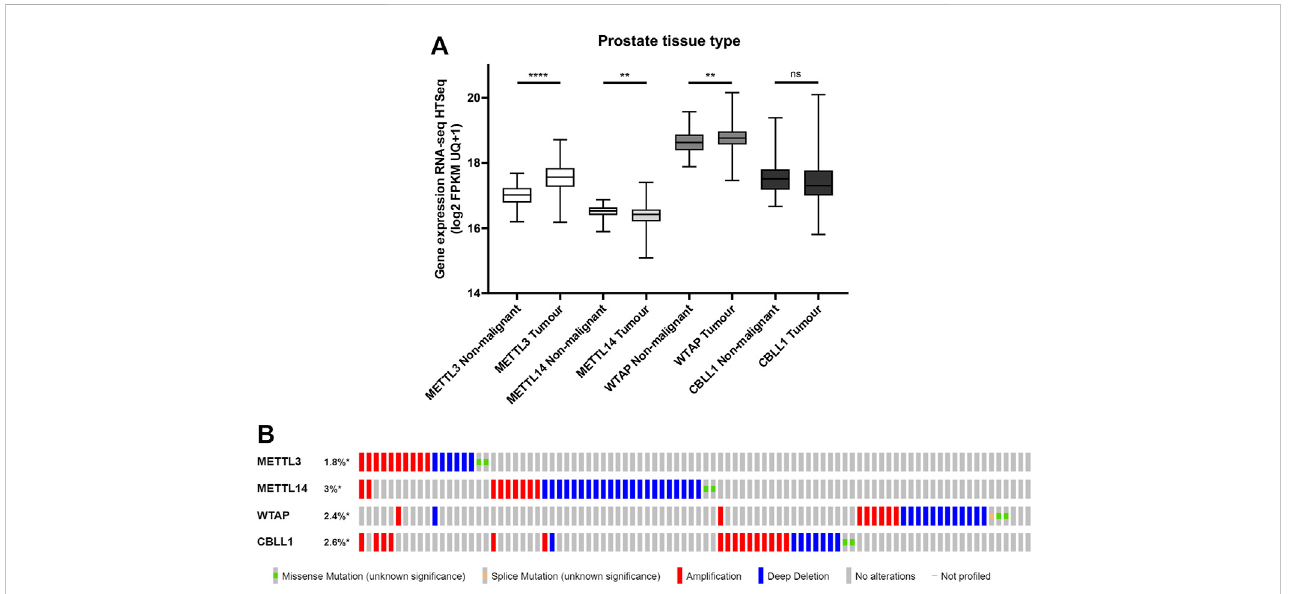
FIGURE 1 METTL3, METTL14, WTAP and CBLL1 expression in non-malignant and PCa tissue and genetic alteration analysis. Data from the GDC TCGA Prostate Cancer(PRAD)datasetweredownloadedfromUSCSXena[ (A) ; n =623]. METTL3,METTL14,WTAP and CBLL1 expressioninnon-malignantprostatetissuewas comparedwithprimaryprostateadenocarcinomaspecimens.ThecBioPortalforCancerGenomicswasutilisedtoassesstheincidenceofampli fi cation,deep deletion and mutation of METTL3, METTL14, WTAP and CBLL1 in patients with adenocarcinoma, metastatic adenocarcinoma and neuroendocrine PCa [ (B) ; n = 1,059]. ns, not signi fi cant; ** p ≤ .005, **** p ≤ .0001 by unpaired t